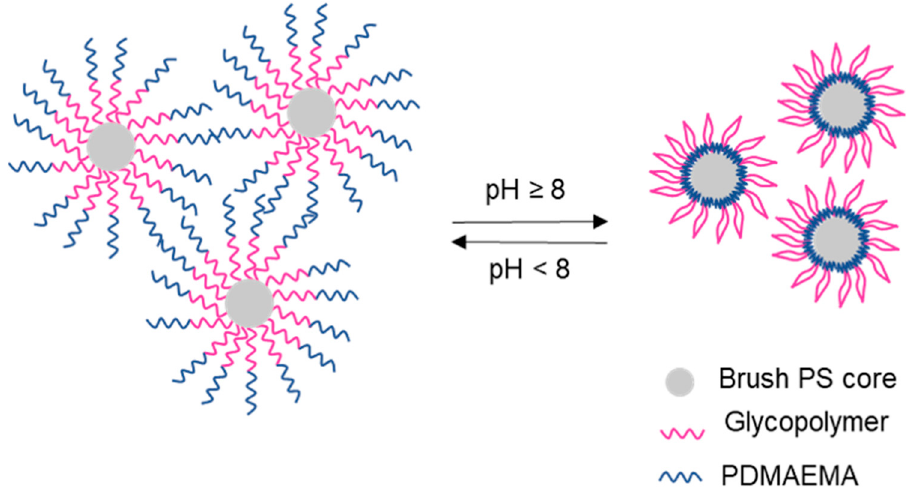
Figure 11. pH-responsive behavior of PMAGal- b -PDMAEMA block copolymer brushes at T > LCST.